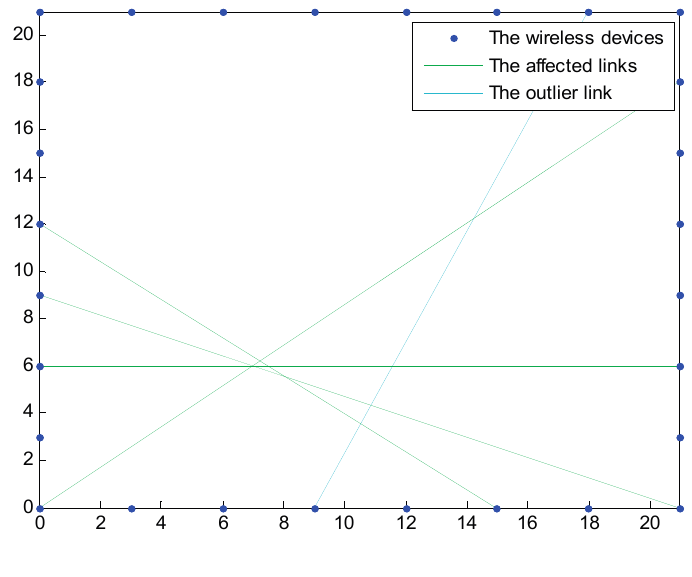
Figure 2 . Affected links and outlier